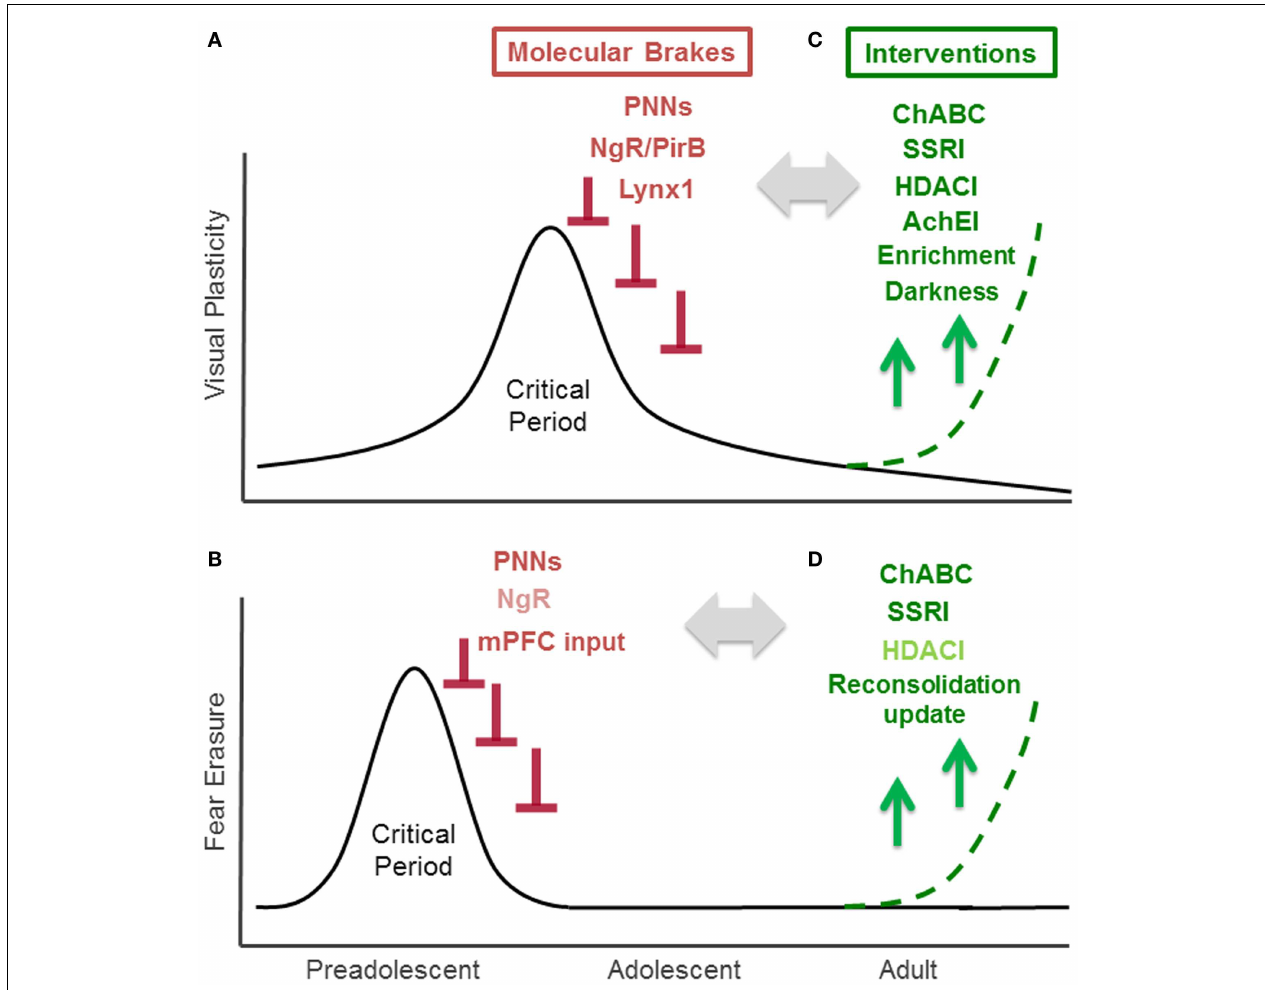
24days or later fails to bar fear memories from re-emerging. Increased PNNs in the amygdala and maturation of input from medial prefrontal cortex (mPFC) to amygdala contribute to the closure of this critical period. Nogo receptor (NgR: colored in light red) also limits fear extinction, but its contribution on fear erasure is not tested. (C) Interventions for enhancing visual cortex plasticity in the adult: counteracting molecular brakes through pharmacological (ChABC, SSRI, HDACI, AChEI: colored in green) and behavioral (environmental enrichment, dark exposure) approaches is a promising therapeutic strategic for recovery from amblyopia. (D) Interventions for fear erasure in the adult: juvenile-like plasticity can be reintroduced in adulthood through pharmacological treatment (ChABC, SSRI treatment) or reconsolidation update. HDACI administration (colored in light green) enhances extinction, but its effect on fear erasure has not been examined